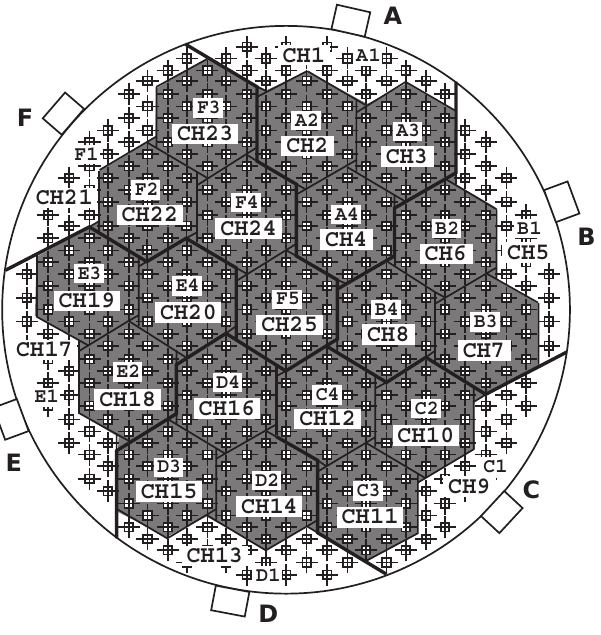
Fig. 1. Layout of the MU radar antenna sub-arrays. The 19 shaded sub-arrays were used to take data independently for imaging analy- sis. All 25 sub-arrays were used for transmission.